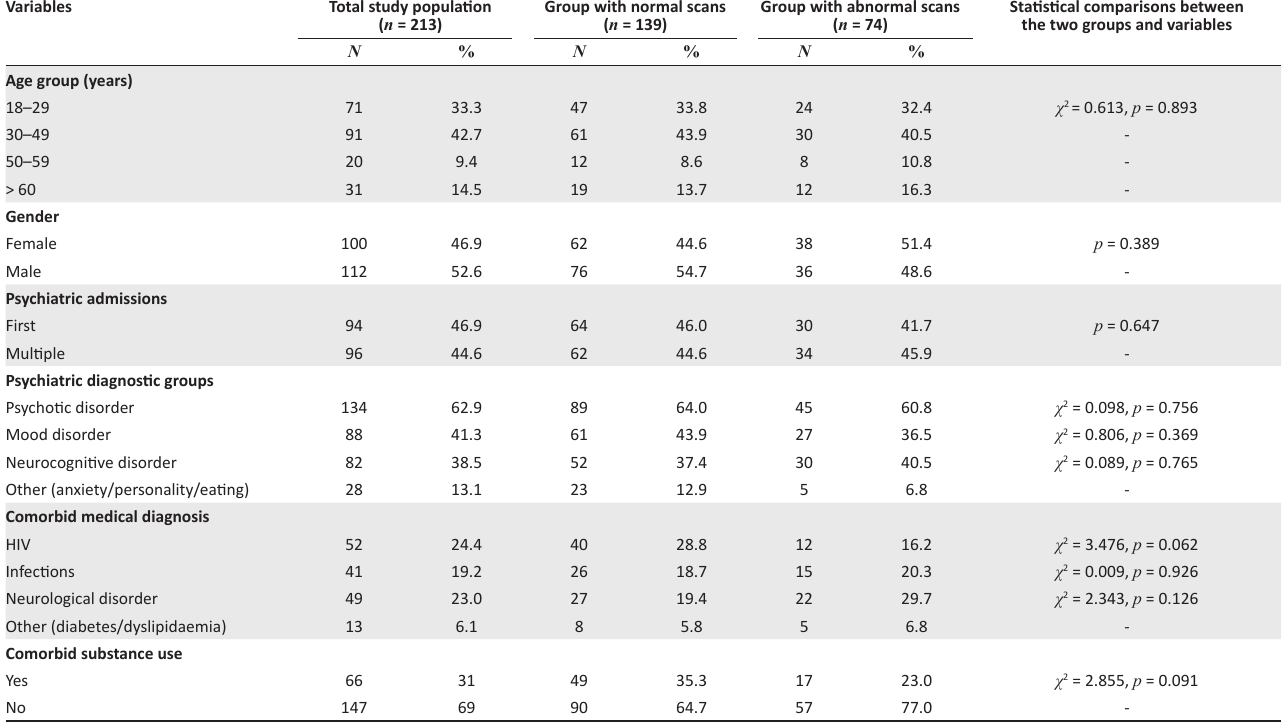
TABLE 1: Frequency distribution of the demographic and clinical characteristics of the study population.